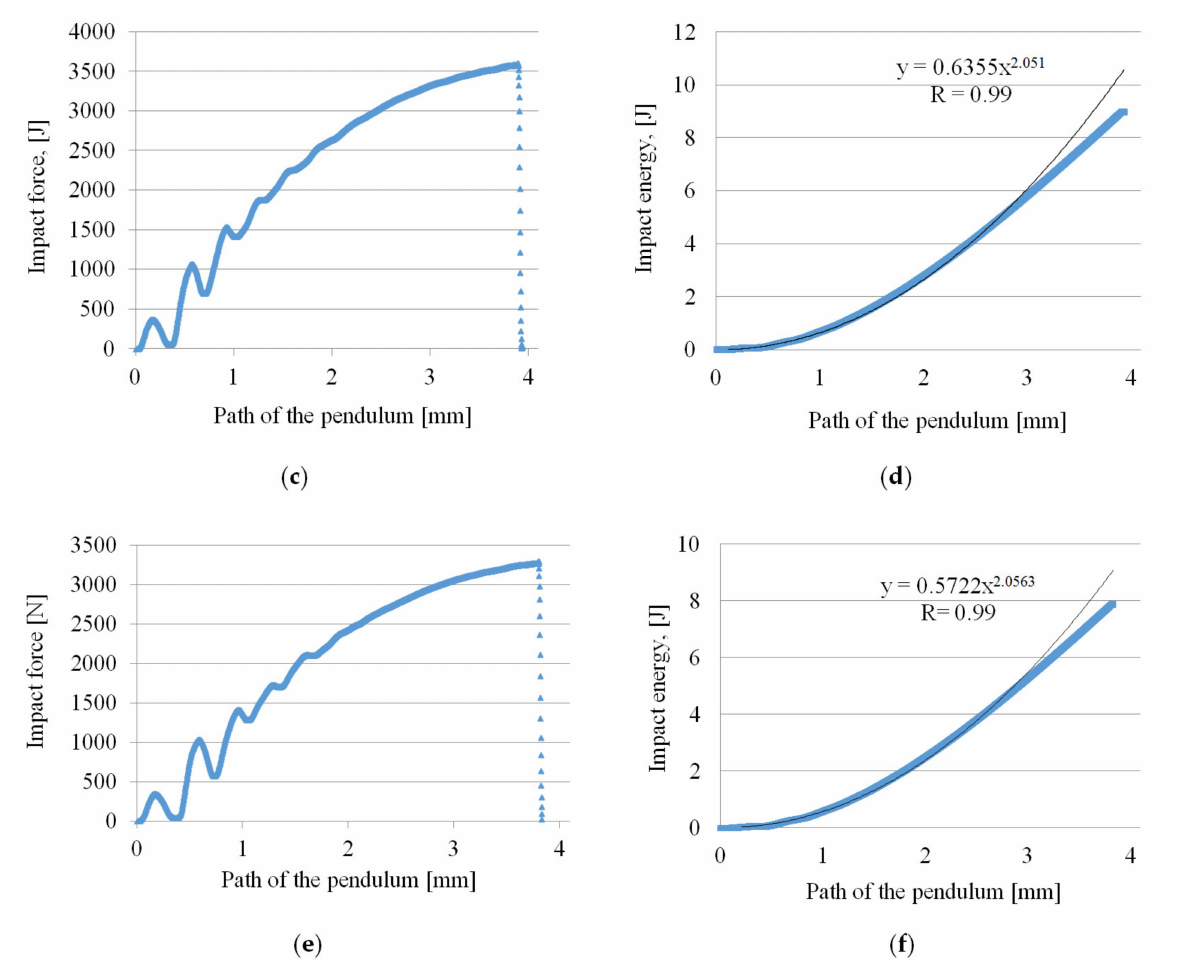
Figure 16. Courses of the impact force and the cumulative impact energy during the impact tests of PA66 GF30 samples with a thickness of 6 mm: ( a , b ) unfoamed moldings A, ( c , d ) foamed moldings B, ( e , f ) foamed moldings